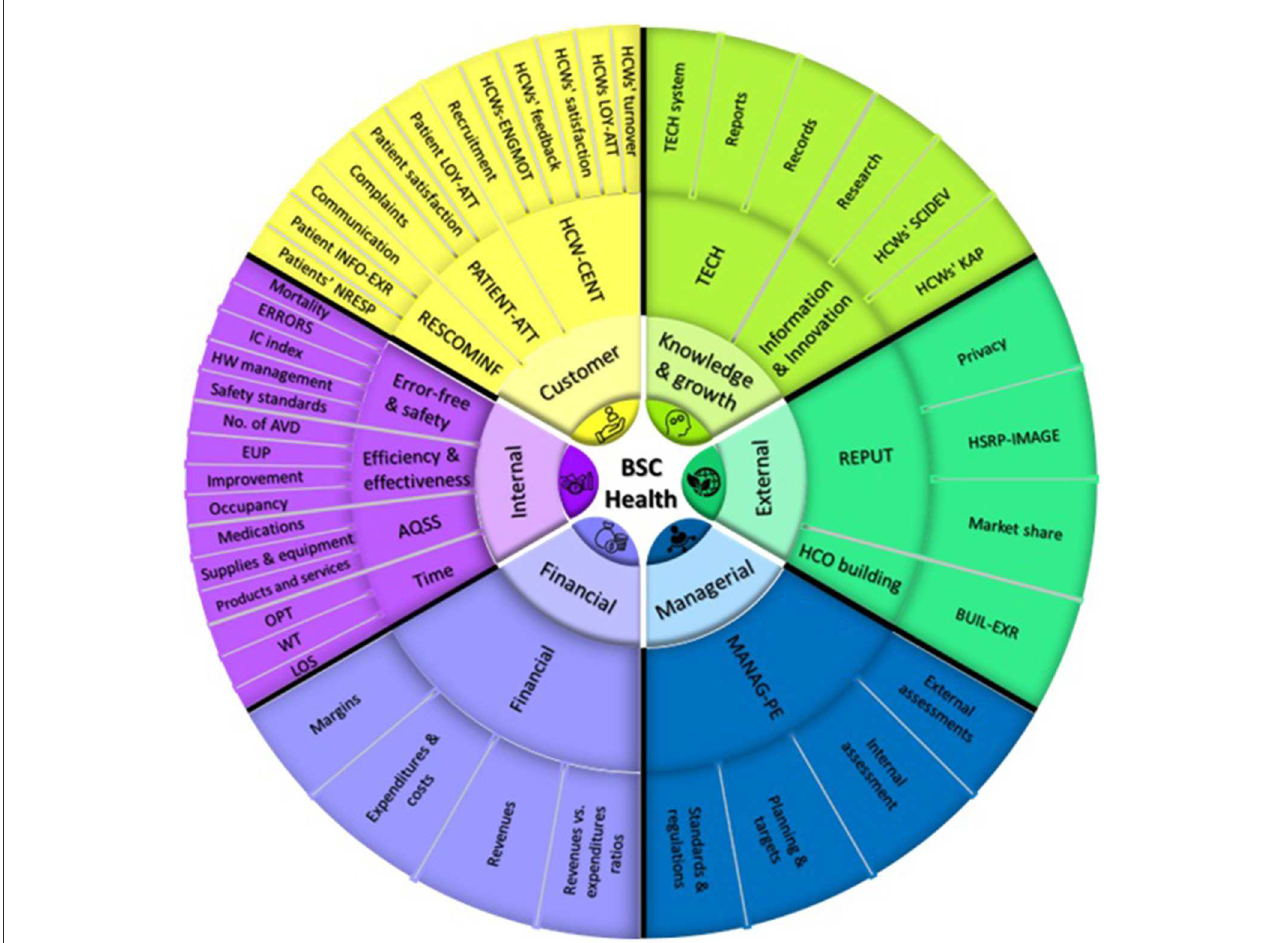
FIGURE3 A summary of BSC perspectives in health care and their contents [source: own elaboration (11) with adaptation]. BSC, balanced scorecard; HCWs, health care workers; HCOs, health care organizations; IC, infection control; HW, health waste; WT, waiting time; LOS, length of stay; KAP, knowledge, attitudes, and practices; TECH, technology; HSRP-IMAGE, hospital social responsibility perceived image; ERRORS, errors, accidents, and complications; No. of AVD, number of admissions, visits, and diseases; EUP, efficiency, utilization, and productivity; AQSS, availability and quality of supplies and services; OPT, operation processing time; RESCOMINF, patient need response, communication, and information provision; PATIENT-ATT, patient attitude; HCW-ENGMOT, health care workers’ engagement and motivation; HCW-CENT, health care workers’ centrality; MANAG-PE, managerial tasks and performance evaluation; HCW-SCIDEV, health care workers’ scientific development; INFO-EXR, information experience; LOY-ATT, loyalty attitudes; BUIL-EXR, building experience; REPUT, community and reputation; NRSP, needs